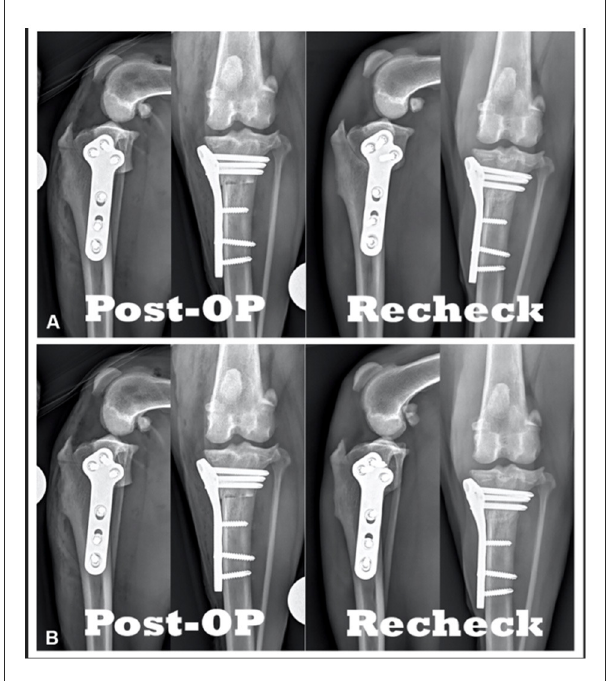
FIGURE4 Comparison of TPLO radiographs of the same patient: (A) Immediately postoperative vs. 6-weeks postoperative radiographs. (B) Immediately postoperative vs. 6-weeks postoperative with slight variation in